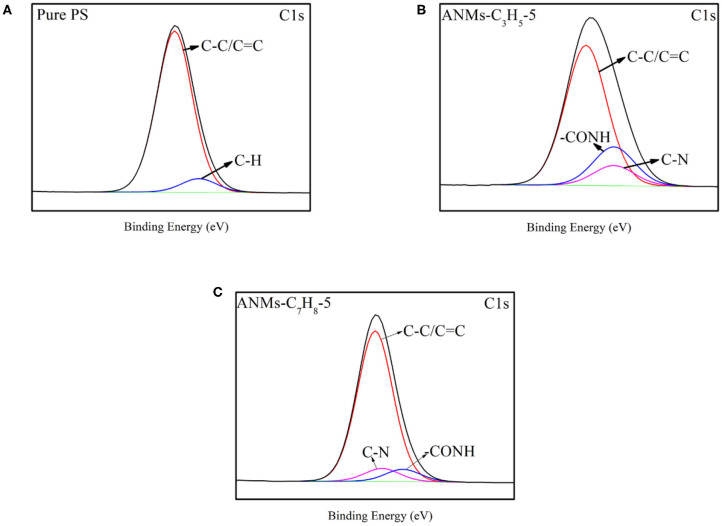
Carbon (1 s) spectra of Pure PS (A), ANMs-C3H5-5/PS (B), and ANMs-C7H8-5/PS (C).